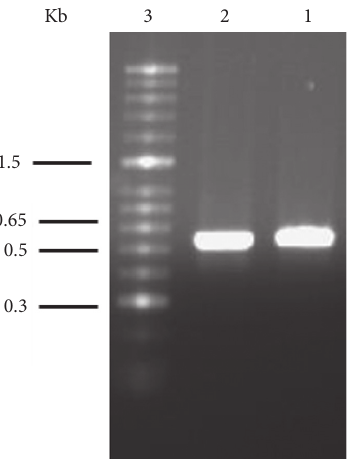
Figure 1: Nested-PCR of T. gondii B1 gen. (1) Control + T. gondii tachyzoites, RH strain. (2) T. gondii oocysts. (3) the DNA marker used. The primers amplified the expected 0.530kb product in samples of T. gondii oocysts used for the evaluation of AgNPs with 1.0% agarose gel.